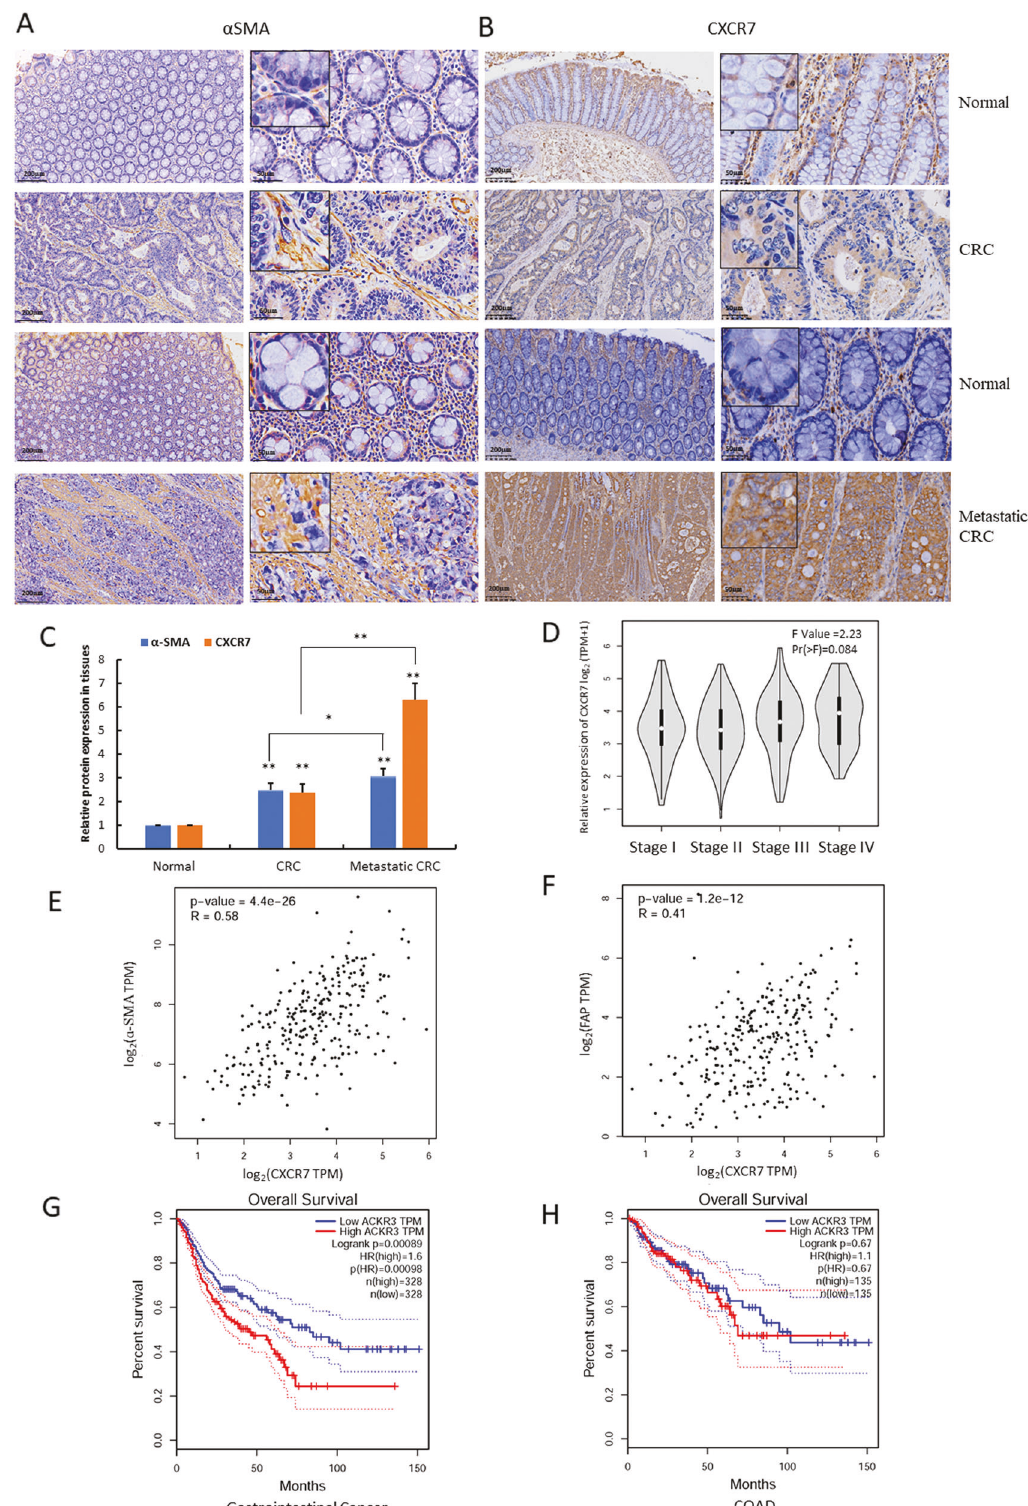
MATERIALS AND METHODS Cell culture and cell transfection Human CRC cell lines HCT116 and SW620 were purchased from the American Type Culture Collection (ATCC) and were cultured in RPMI 1640 medium supplemented with 10% fetal bovine serum (FBS). Cell Death and Disease (2022)